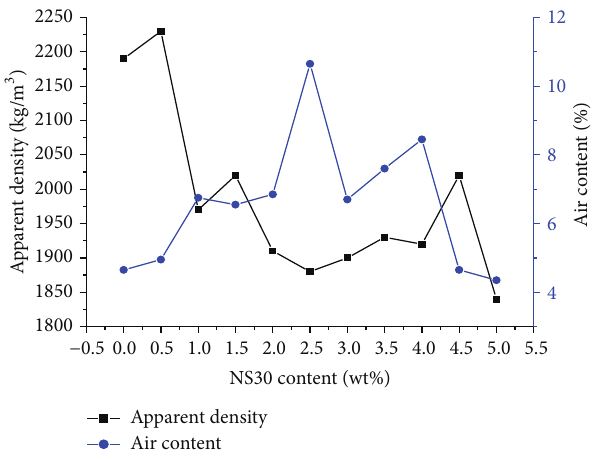
Figure 6: Influence of NS30 content on air content and apparent density of the mortar.